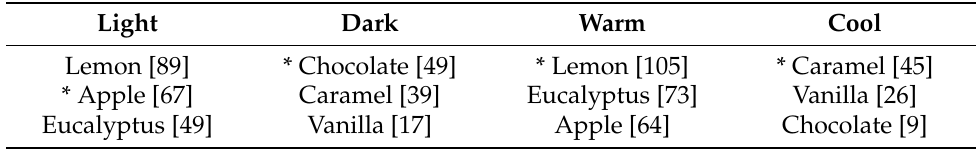
Table 10. Scent candidates for scent—color dimension